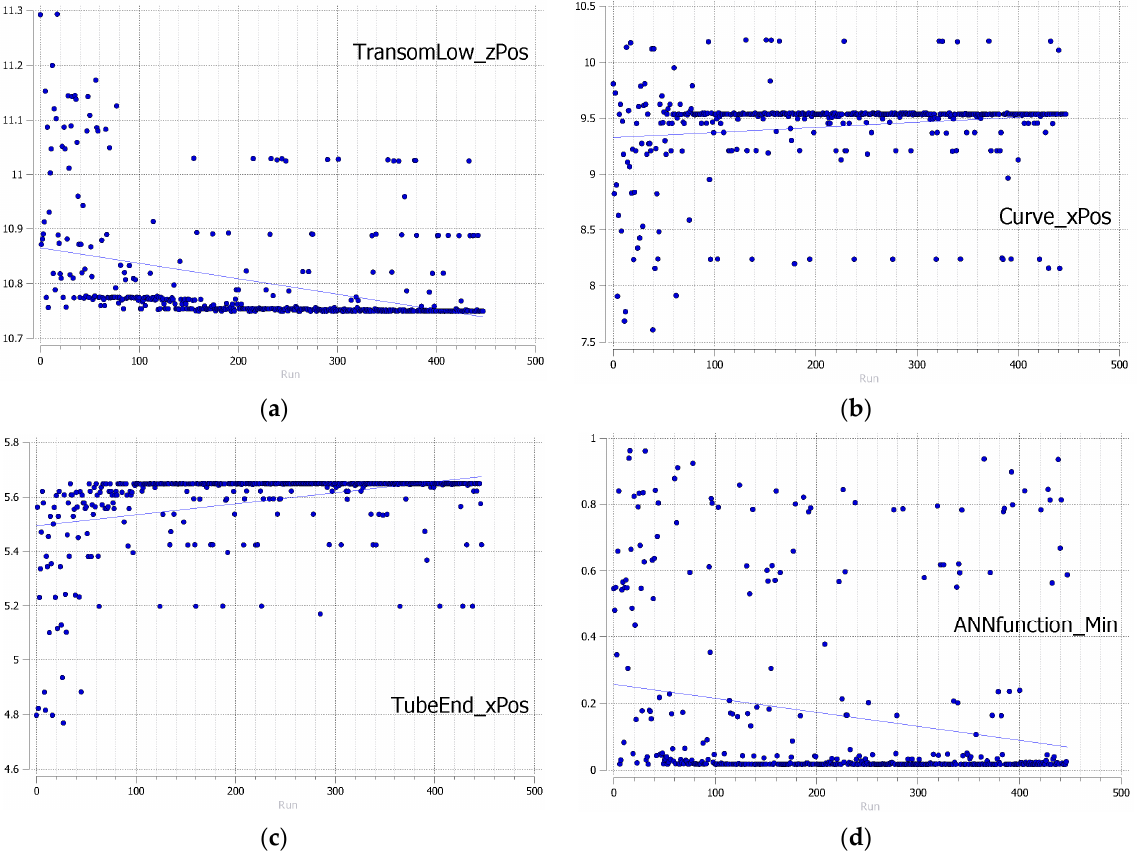
Figure 11. ( a – d ) Convergence of the three stern parameters ( a – c ) and the minimization of ANN’s function ( d ).